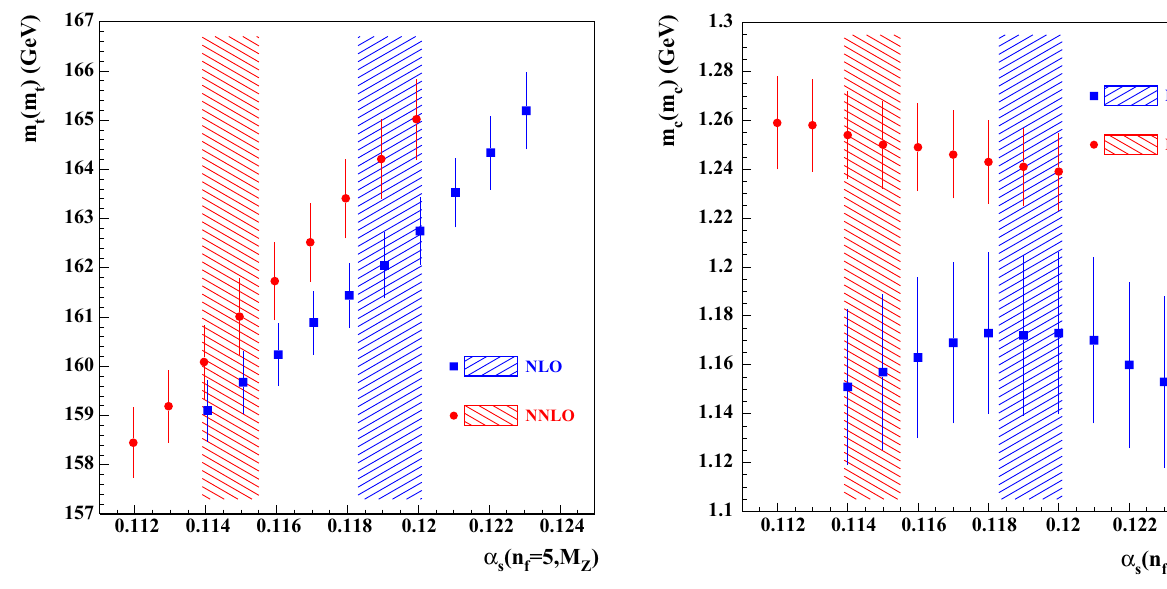
Fig. 3 The MS values of the t -quark mass m t ( m t ) obtained in the variants of the NLO ABMP16 fit with α comparison to ones at NNLO (circles). The left-tilted and right-tilted hatchrepresentthe1 σ bandsfor α nominal fits at NLO and NNLO, respectively. The points are slightly shifted left and right to prevent overlapping